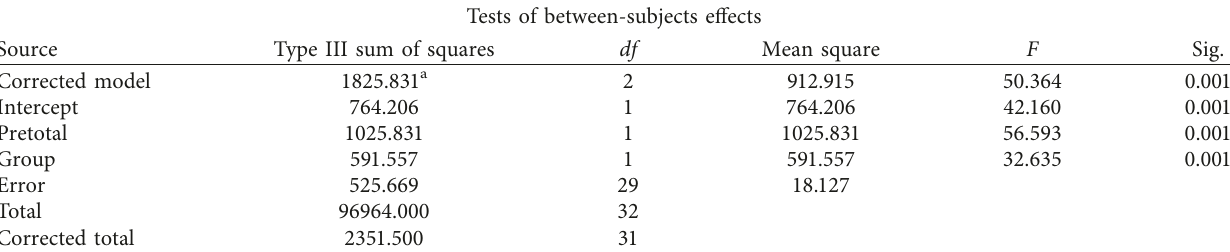
Table 6: ANCOVA of average achiever students.